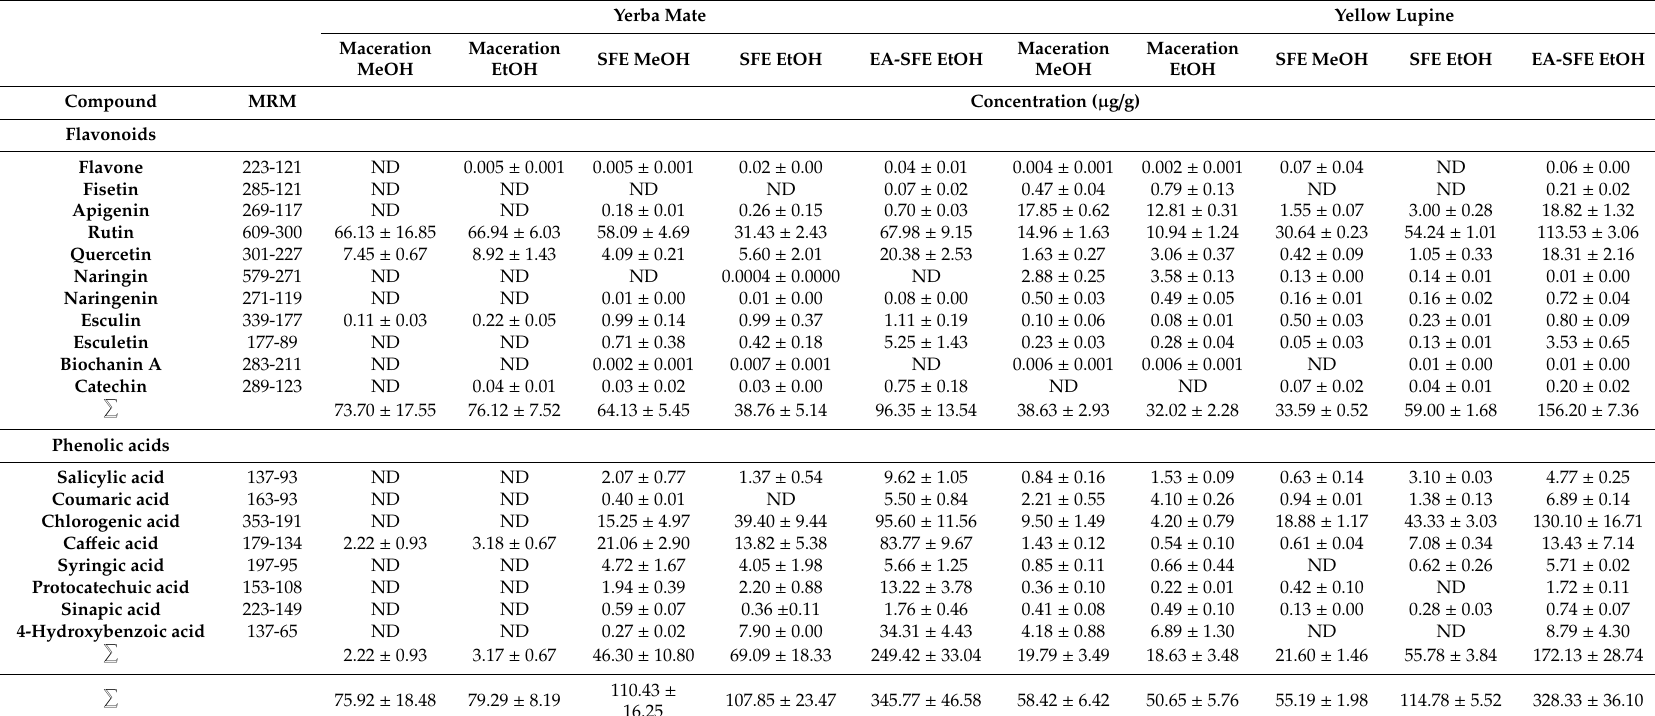
Table 2. Results of HPLC-MS / MS analysis of yerba mate and yellow lupine extracts.